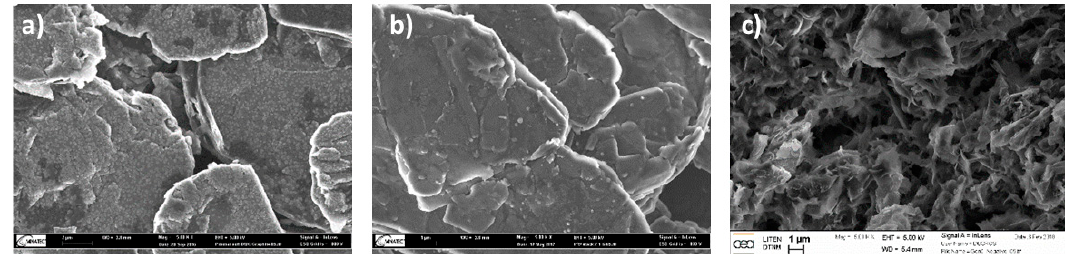
Figure 4. SEM images comparing the graphite electrodes of the ( a ) Fresh Cell (i.e., after formation), ( b ) Cell A and ( c ) Cell B (cycled at 0.3C and 2C, respectively). All the samples were taken from the electrode at the beginning of the cell stack.